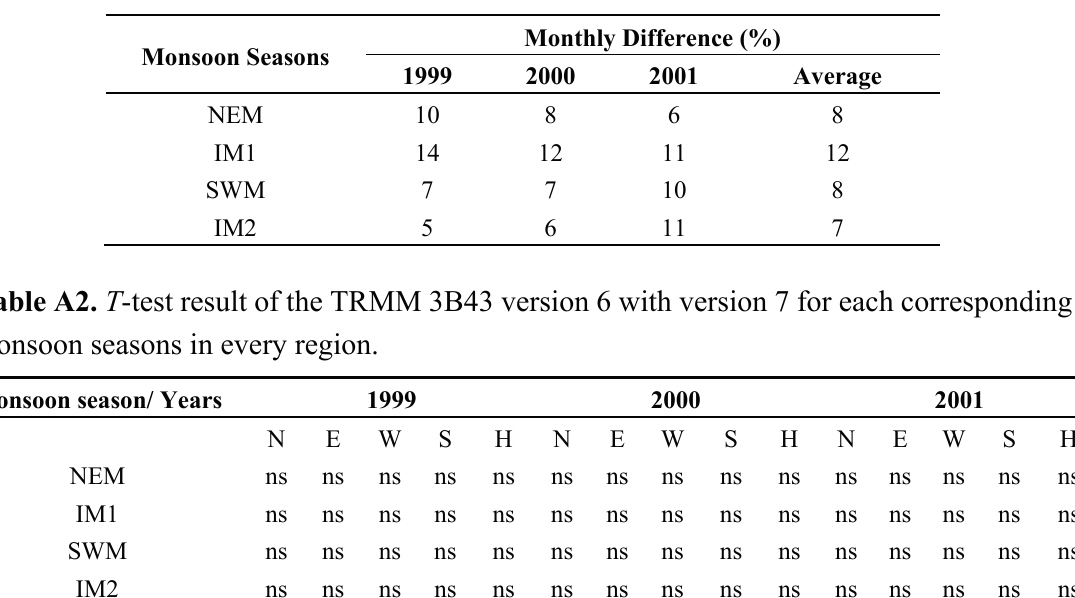
Table A1. Average monthly rainfall differences derived from TRMM 3B43 version 6 and 7 for Peninsular Malaysia from 1999 to 2001.